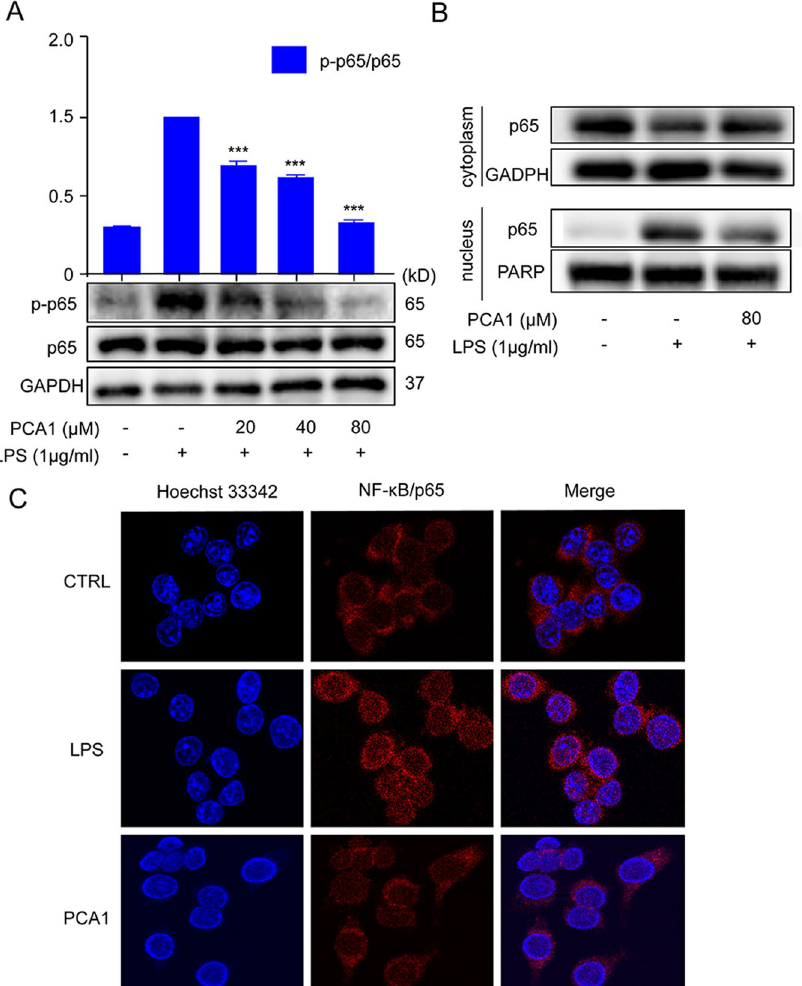
for 2 h were induced by LPS (1 μ g/ml) for 2 h. p-p65 and p65 protein level was detected by Western blotting. ( B ) RAW264.7 cells were pretreated with PCA1 (80 μ M) for 1 h and then stimulated with LPS (1 μ g/ml) for 1 h. The localization of p65 in the cytoplasm and nucleus were detected by Western blotting. ( C ) RAW264.7 cells treated with for PCA1 for 2 h were included with LPS for 2 h. p65 translocation was determined using immunofluorescence analysis. The grouping of gels/blots cropped from different parts of the same gel (targets vs loading control) or different gels (phosphorylation). The full blots are shown in Supplementary Information. *** p < 0.001 versus the LPS